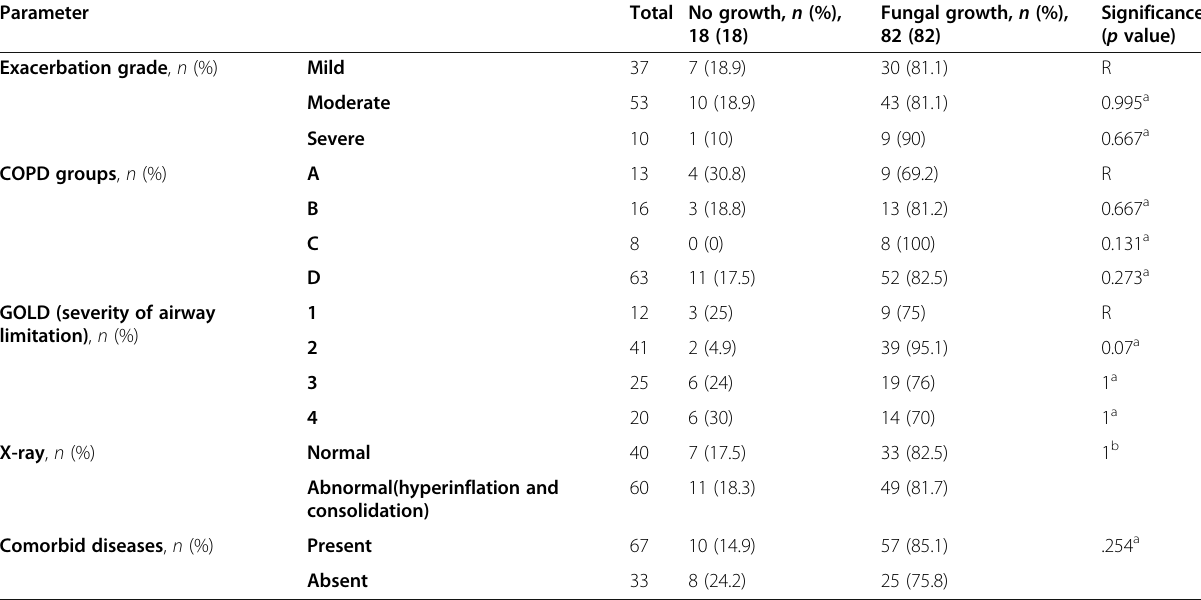
Table 8 Fungal isolates in association to clinical and radiological data of studied patients Parameter Total No growth, n (%),